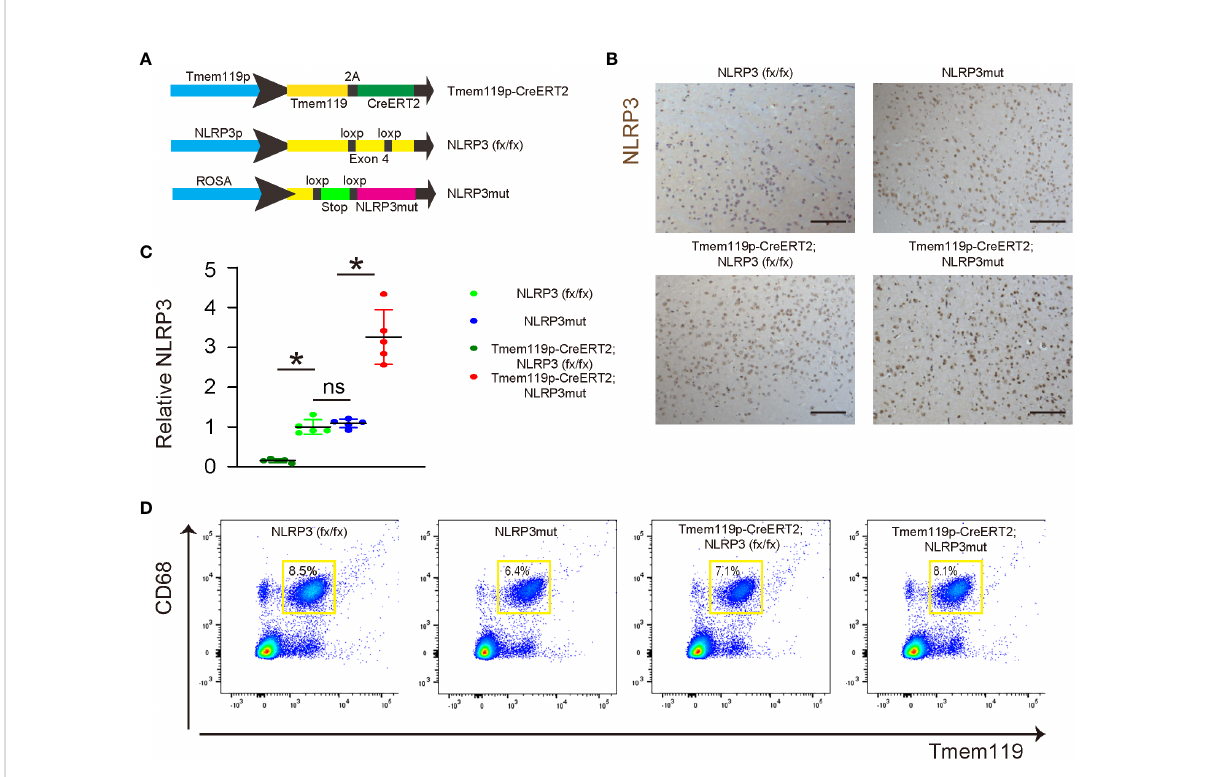
FIGURE 3 Generation of microglia-speci fi c NLRP3-KO or NLRP3-overexpressing mice. (A) Illustration of mice with microglia-speci fi c depletion of NLRP3 (Tmem119p-CreERT2; NLRP3 (fx/fx)) and their control NLRP3(fx/fx) mice, as well as mice with microglia-speci fi c persistent expression of NLRP3 (Tmem119p-CreERT2; NLRP3mut) and their control NLRP3mut mice. (B) NLRP3 staining was done in spinal discs from tamoxifen-challenged mice. (C, D) Dissociated cells from spinal discs of the mice were FAC sorted for CD68+Tmem119+ microglia, the NLRP3 levels of which were checked by ELISA. (C) The relative levels to those from NLRP3(fx/fx) (=1) were shown. (D) The presentative fl ow charts of FACS sorting CD68 +Tmem119+ microglia. *p<0.05. ns, non-signi fi cant. Scale bars are